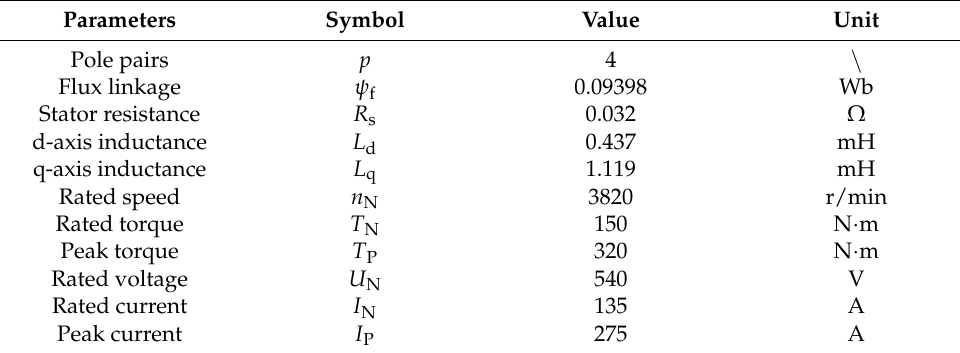
Figure 5. Diagram of experimental system. Table 1. The parameters of the IPMSM.